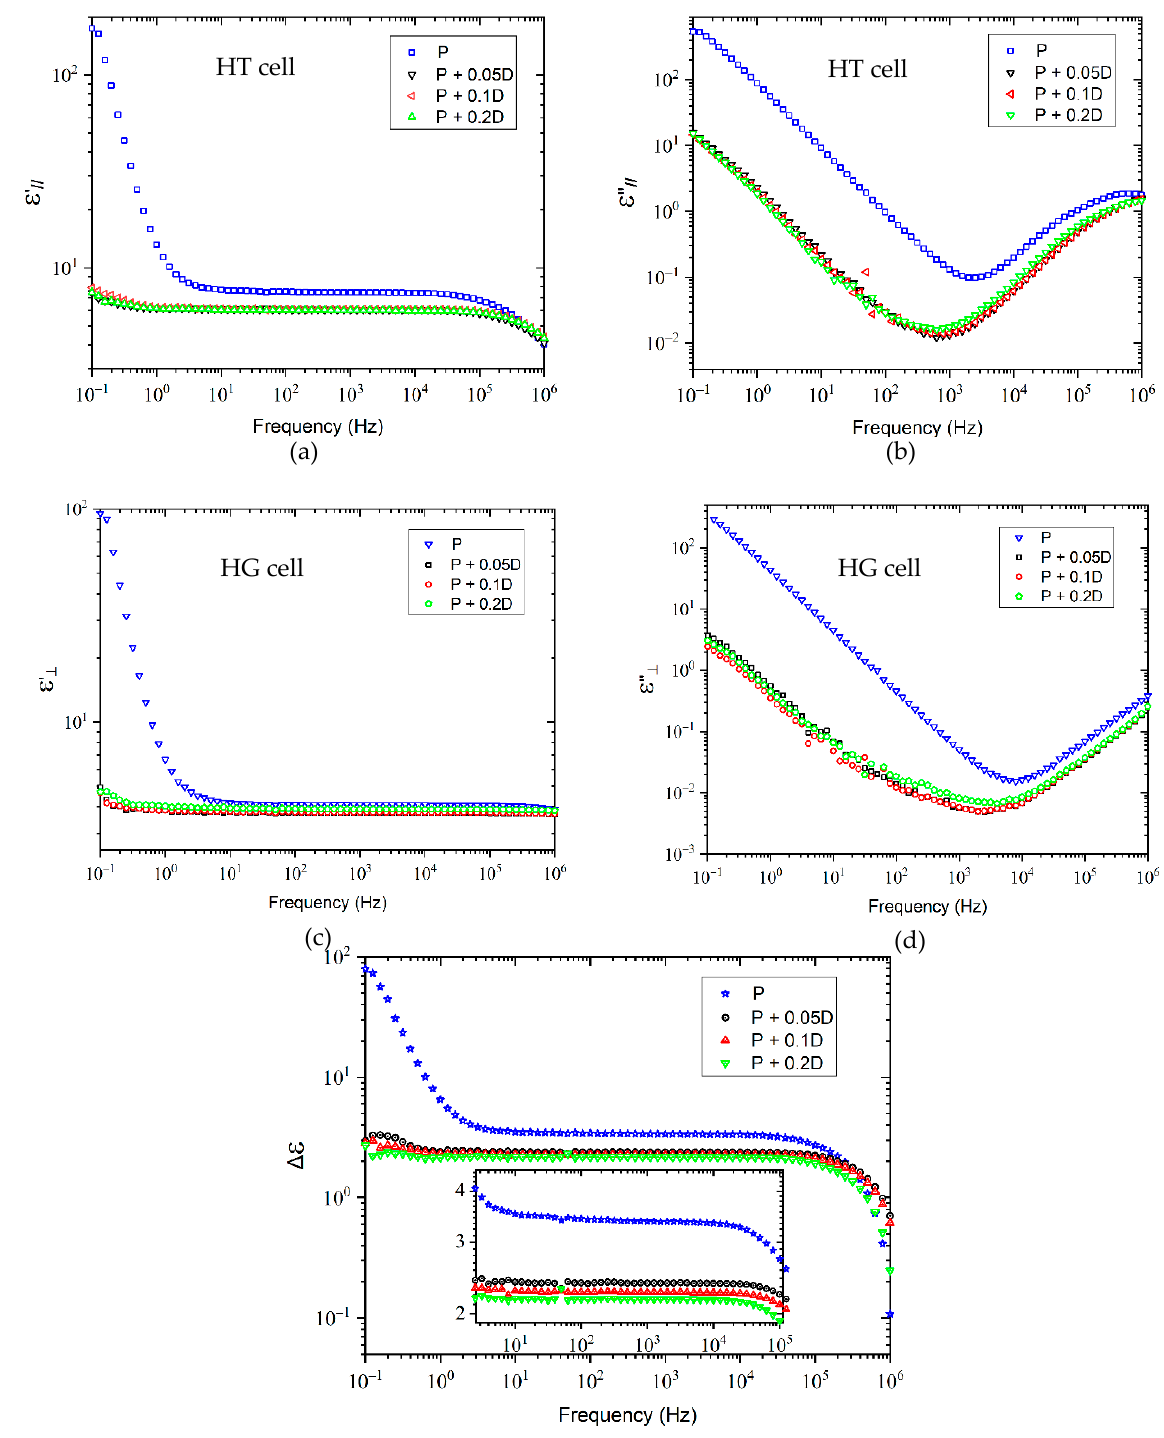
Figure 3. Dielectric permittivity of purified LCs doped with different concentrations of DNPs (0.05, 0.1, and 0.2 wt%): ( a ) real and ( b ) imaginary parts in homeotropic alignment, ( c ) real and ( d ) imaginary parts in homogeneous alignment, and ( e ) dielectric anisotropy. The spectra were measured under identical experimental conditions (P stands for purified LC mixtures; P + 0.05D, P + 0.1D, and P + 0.2D correspond to purified LC mixtures doped with 0.05, 0.1, and 0.2 wt% of DNPs, respectively).